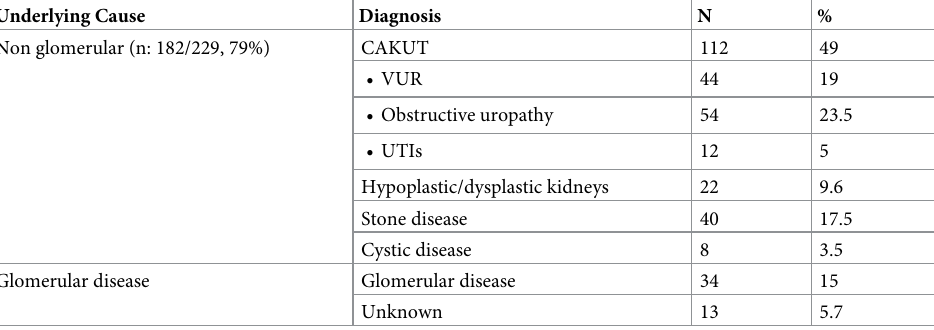
Table 1. Underlying diagnosis among children presenting with